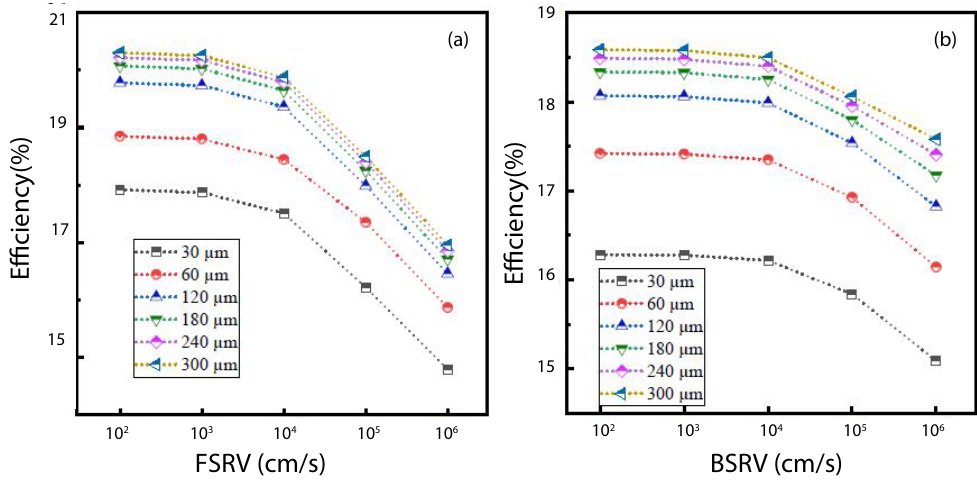
Figure 9. Efficiency variation with respect to ( a ) FSRV and ( b )